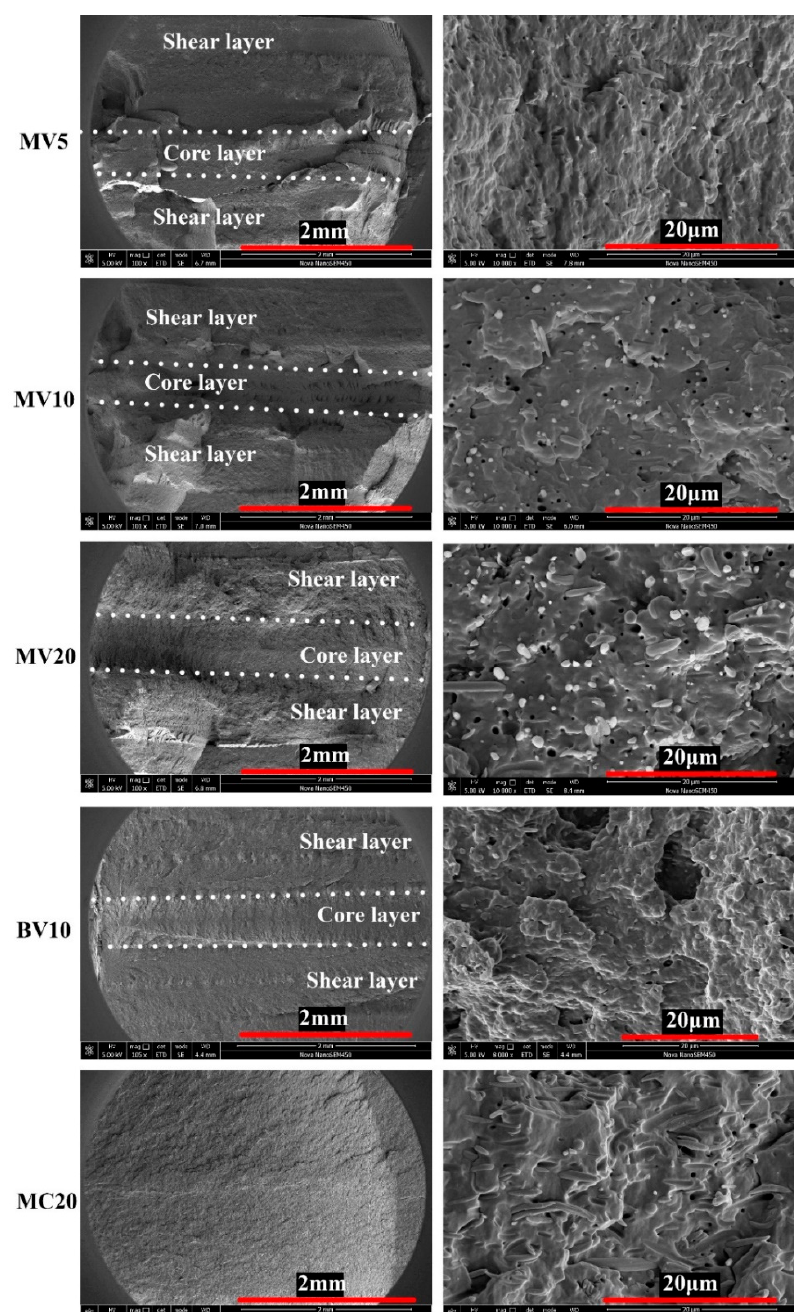
Figure 8. SEM of impact fracture surfaces of selected samples.